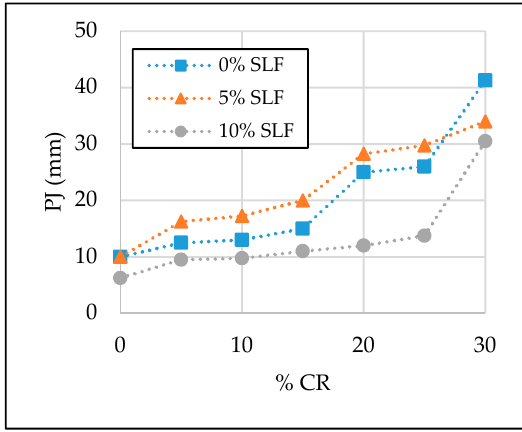
ff ect of crumb rubber and silica fume on J-ring value Figure 9. The effect of crumb rubber and silica fume on J-ring value (PJ). Figure 9. The e Figure 9. The effect of crumb rubber and silica fume on J-ring value (PJ). Figure 9. The effect of crumb rubber and silica fume on J-ring value (PJ).